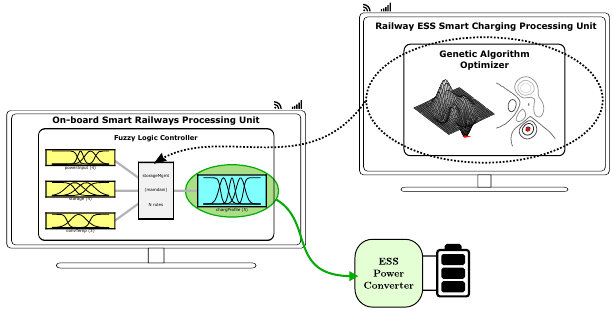
Figure 1. Proposed two-level hierarchical architecture tor the railway